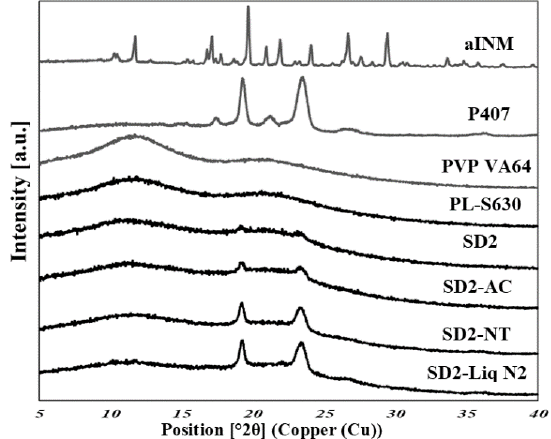
Figure 6. ( a ) XRPD diffractograms of the pure components and ( b ) hyper DSC thermograms of pure components after heating at 100 °C/min to 180 °C. INM is transformed to the amorphous form. ( b ) nature. Glass transition temperature [ T g ] is indicated by a tick.